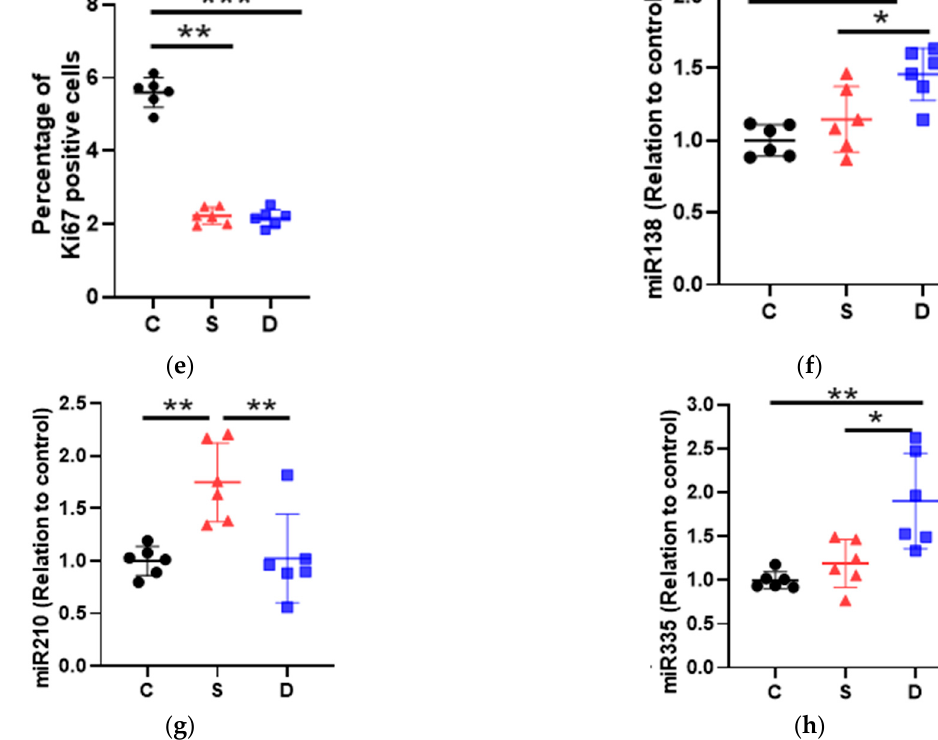
Figure 1. The changes of cell viability and miRNAs after inhalational anesthesia. ( a ) Neuroglioma (H4) cell migration analysis with wound healing assay after 2 h of inhalational anesthesia: control (left), 3.6% sevoflurane (middle) and 10.4% desflurane (right), at 0 h later (upper), 24 h later (middle) and 48 h later (bottom). The microscopic images at 0, 24 and 48 h after general anesthesia. ( b ) The comparison between anesthetics in percentage of gap closure by wound healing assay. ( c ) Cell proliferation analysis with CCK8 assay relative to control group. ( d ) Ki67 immunofluorescence staining: Ki67 (red), marker for cell proliferation, in control (left), sevoflurane- (middle) and desflurane-treated (right) H4 cells, counter-stained with DAPI (blue); x20 magnification, scale bar = 20 μ m. ( e ) Comparison of percentage of Ki67 positive cells at 24 h after anesthesia exposure. ( f – h ) miRNA expressions evaluated with qRT-PCR compared to control group just after anesthesia exposure: ( f ) miR-138 (HIF-1 α regulator), ( g ) miR-210 (HIF-1 α regulator) and ( h ) miR-335 (MMP9 regulator). Data showed as plots and mean ± SD (n = 6). * p < 0.05, ** p < 0.01, *** p < 0.001; one-way ANOVA with Tukey-Kramer compared to the control group. C: control, S: sevoflurane, D: desflurane and CCK8: cell count kit 8.